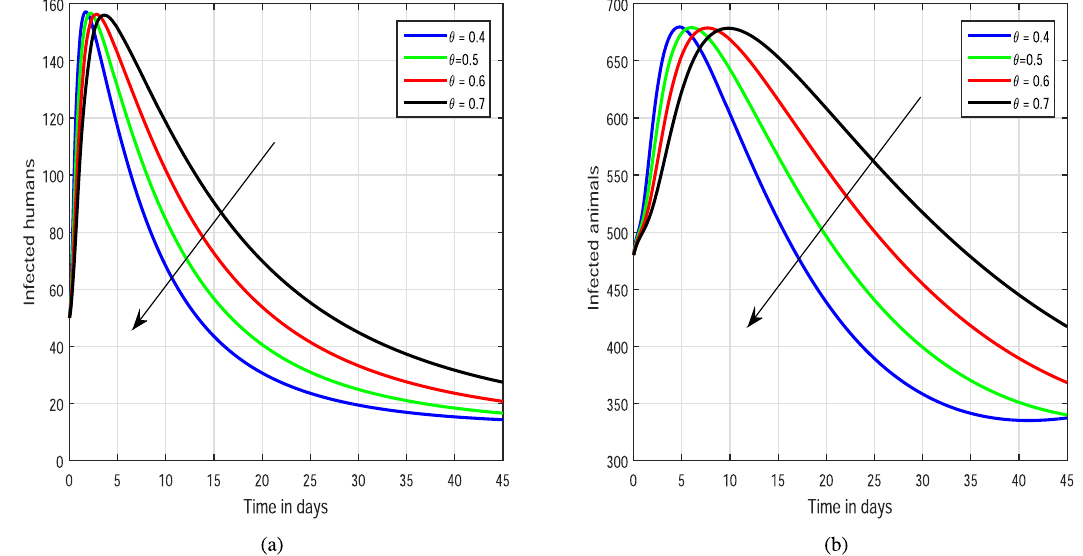
Figure 3: Numerical results showing the dynamical behaviour of infected individuals of the suggested model ( 9 ) of zoonotic infection with variation of θ , i.e. = θ 0.4, 0.5, 0.6 , and